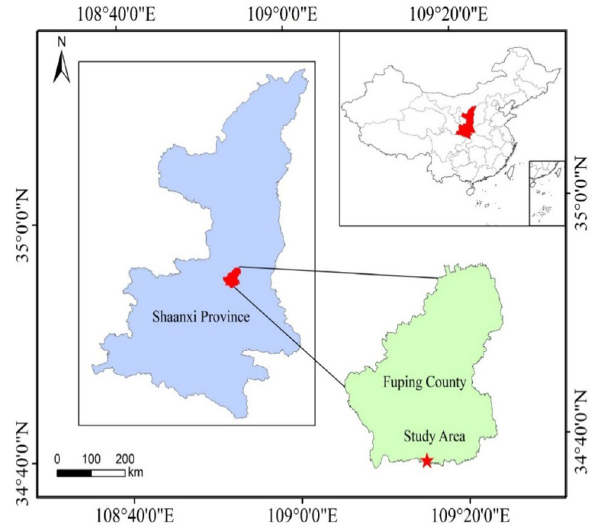
Figure 5. Location map of long-term field experiment area. The map was produced with ESRI ArcGIS software (version 10.3; http:// www. esri. com/ sofwa re/ arcgis/ arcgis- for- deskt op).